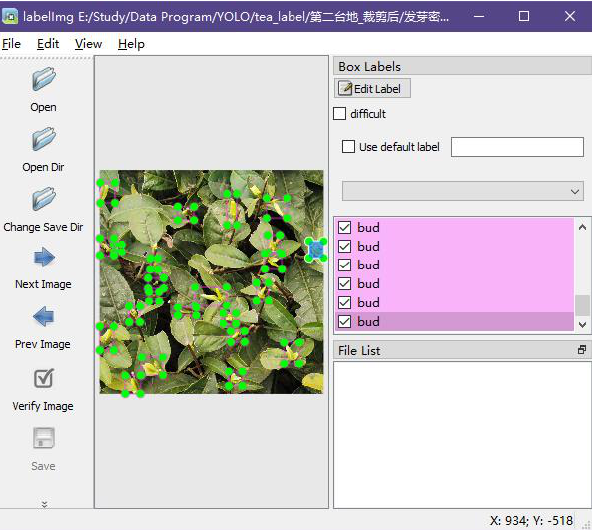
Figure 5. Image labeling software.